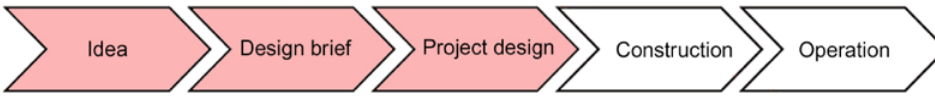
Figure 3 The phases of Danish building industry (FRI & Danske Ark, 2012). The phases in this article